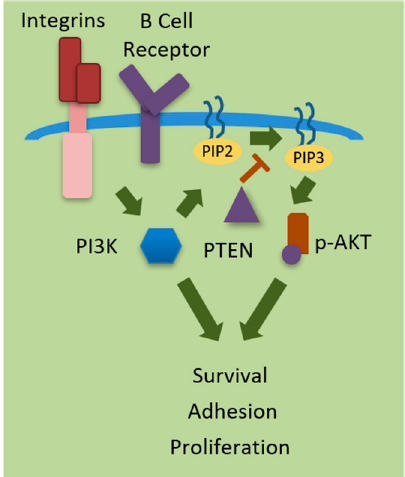
Figure 1. Phosphoinositide 3-kinases (PI3Ks) regulate cellular processes including cell survival, adhesion, and proliferation. PI3K is activated by receptor tyrosine kinases (RTKs), Integrins, or G- protein coupled receptors (GPCRS) at the surface of the cell. PI3K phosphorylates phosphatidylinositol-diphosphate (PIP2) into phosphatidylinositol triphosphate (PIP3), which in turn activate the serine/threonine kinase AKT regulations survival, adhesion and proliferation. PTEN (phosphatase and tensin homolog deleted from chromosome 10) negatively regulates PI3K signaling. = Activation; ⊥ =